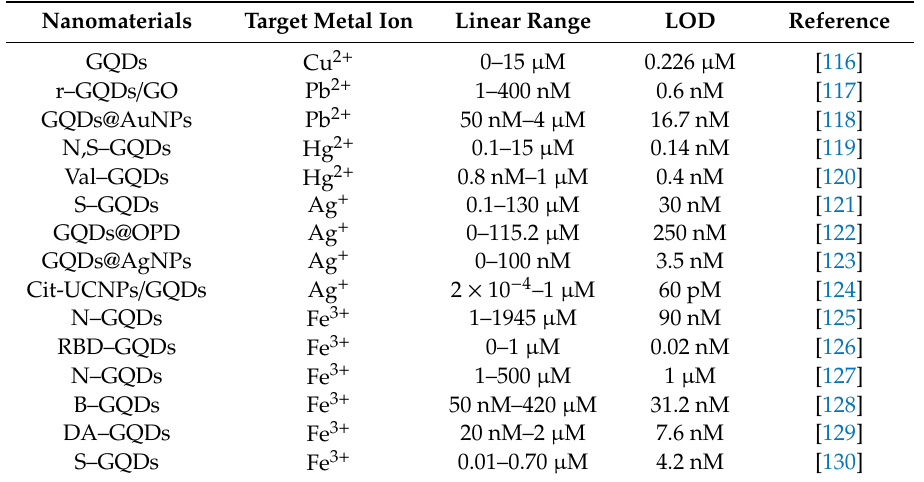
Table 1. Metal ion detection using fluorescence based GQD sensors for biomedical